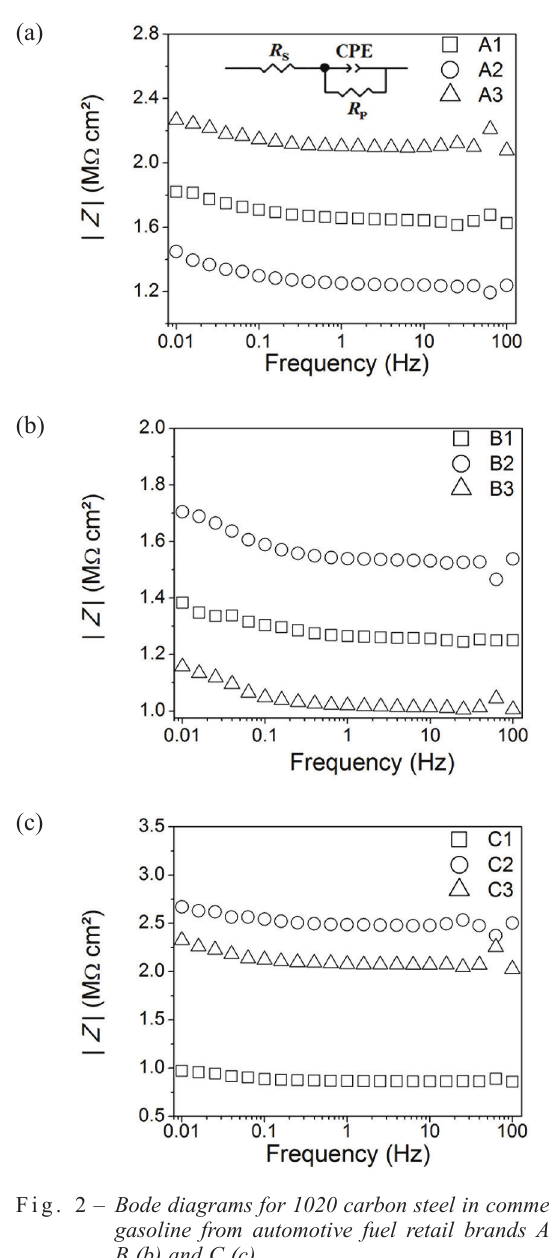
Fig. 3 – Calculated R